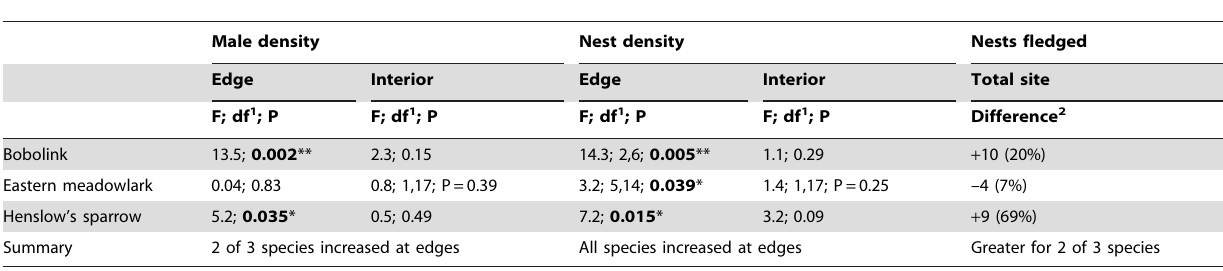
Table 7. Summary of the relative impacts on birds of tree row